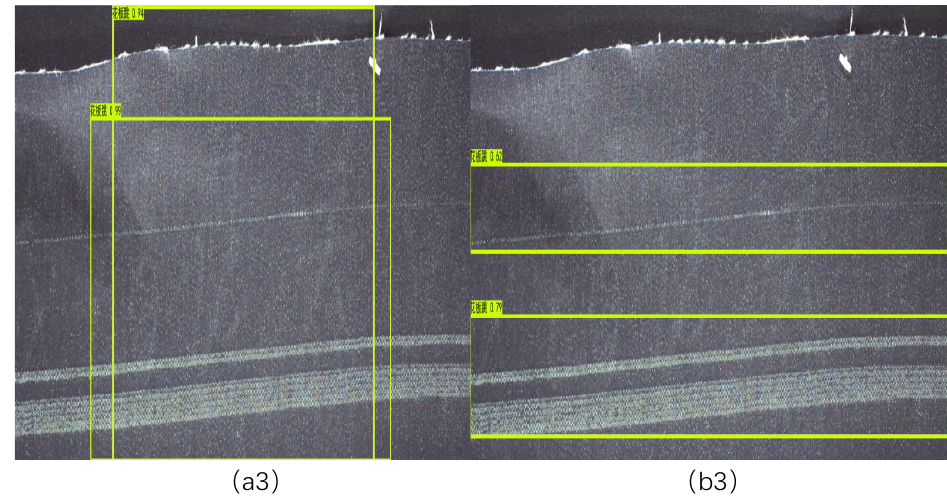
Figure 12. Experimental results of group3. ( a3 ) detection result of YOLOv4; ( b3 ) detection result of improved YOLOv4. Defect sizes are about 416 × 90 pixels.